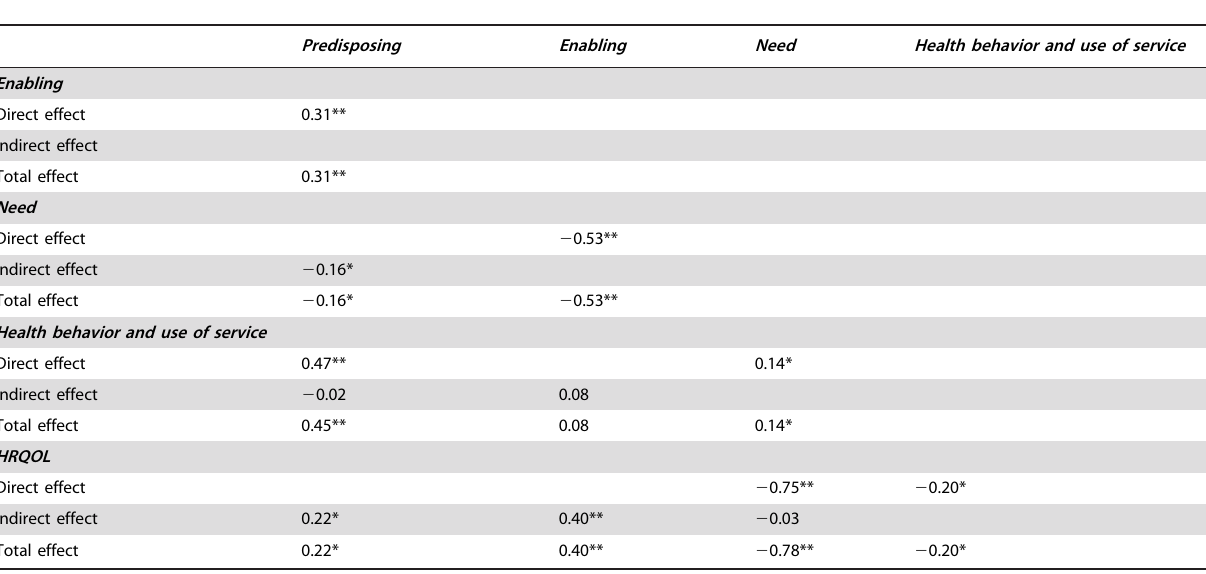
Table 7. Direct, indirect and total effects for Andersen’s model.